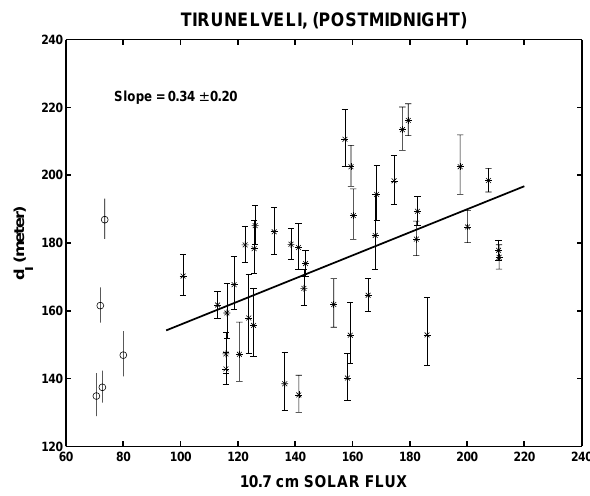
Fig. 5. Mass plot of average eastward drift, V 0 , of the ground scin- tillation pattern as a function of local time for September 2002.